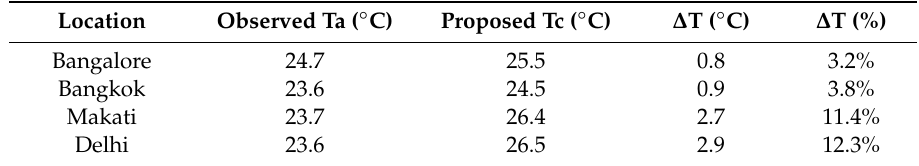
Table 3. Current temperature and comfort temperature analysis for the four thermal comfort studies in the Global South, ordered by the di ff erence in temperatures.